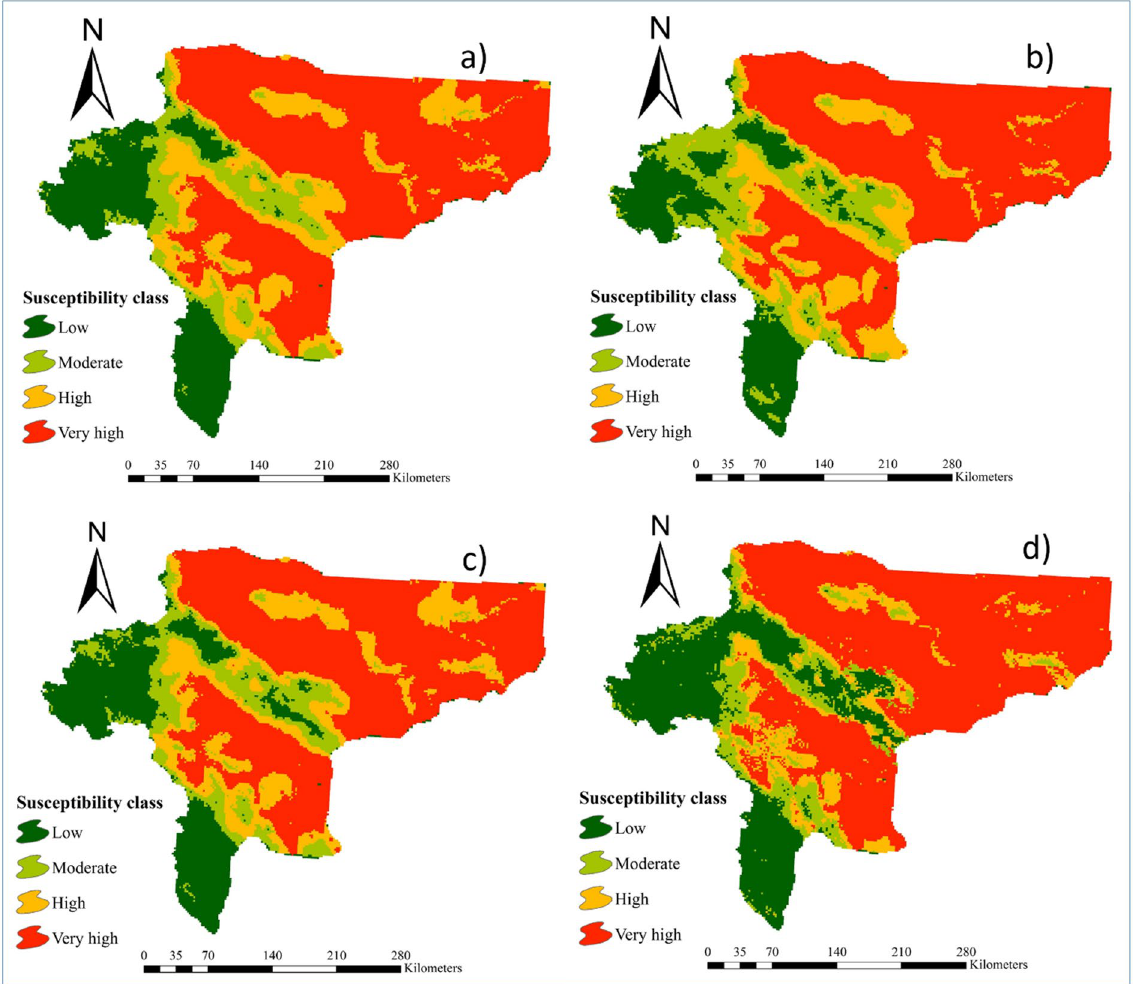
Figure 4. Maps of wind erosion hazard generated by: (a) SVM, (b) RVM, (c) Cubist and (d) ANFIS. The values for pixels was estimated by R software (https ://CRAN.R-proje ct.org/doc/FAQ/R-FAQ.html) and then, values of pixels were mapped by ArcGIS 10.4.1 (https ://www.esri.com/en-us/about /about -esri/overv